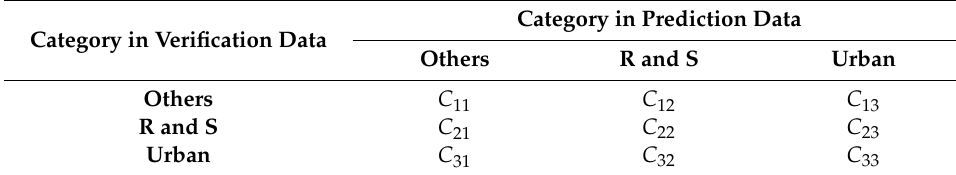
Table 2. Confusion matrix of USR (R and S: Rural and suburban